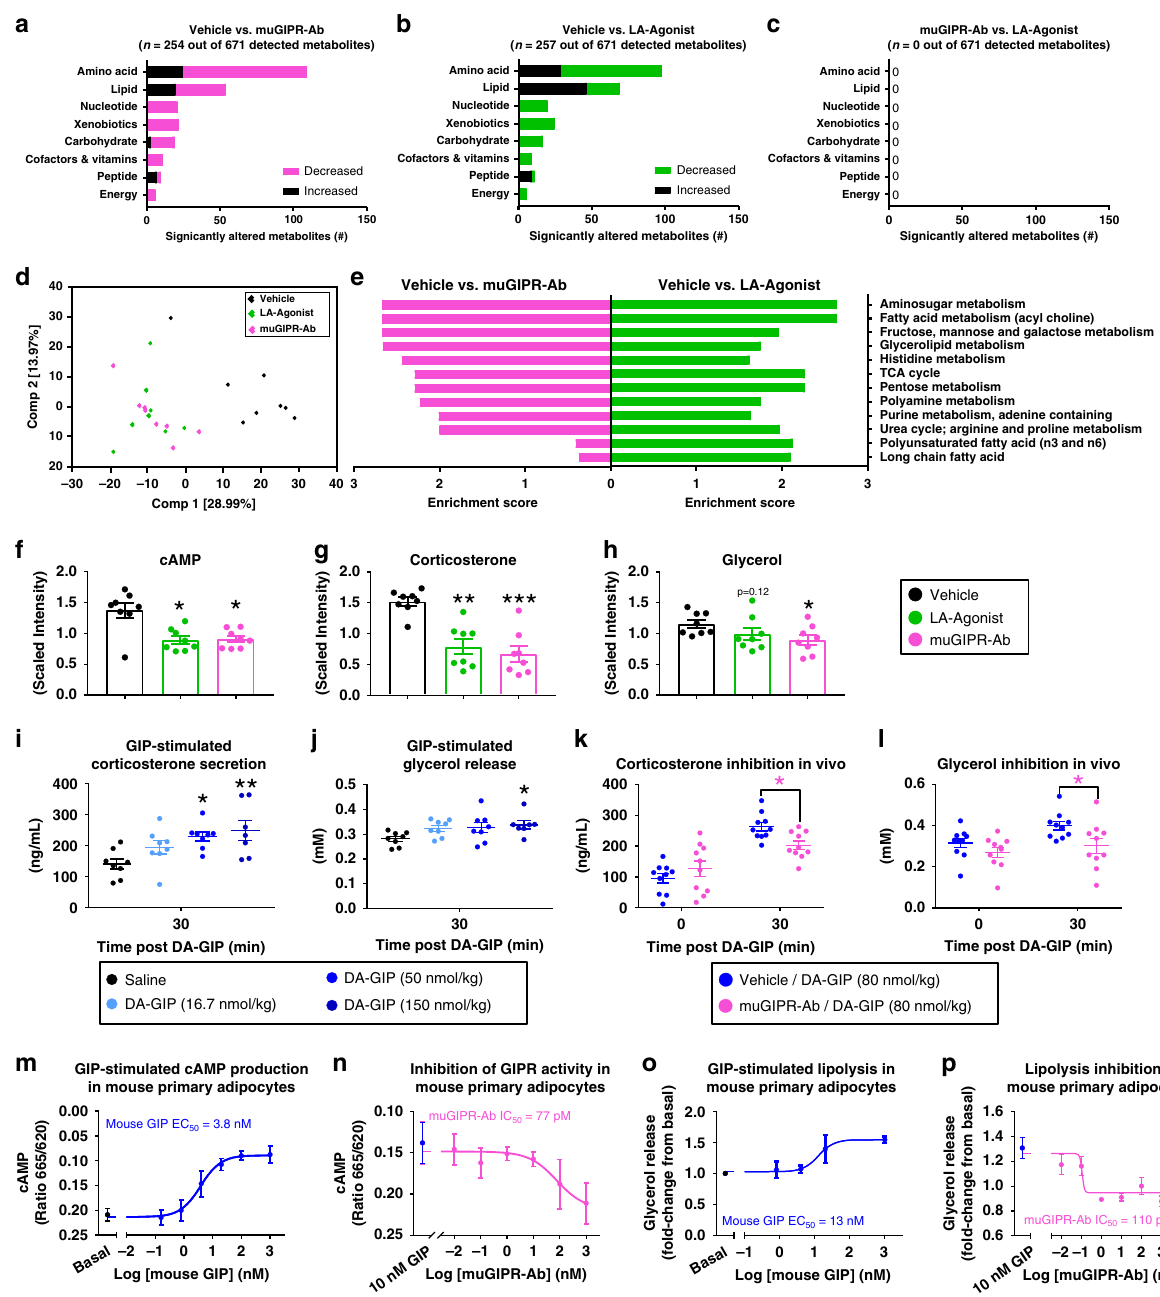
Fig. 3 Chronic LA-Agonist treatment has similar plasma metabolomics as muGIPR-Ab treatment, associated with agonist-induced receptor desensitization. a – e Global metabolomics analysis of plasma samples for vehicle, LA-Agonist, and muGIPR-Ab treated mice (presented in Fig. 2a – k). Signi fi cantly different number of metabolites between a vehicle vs. muGIPR-Ab, b vehicle vs. LA-Agonist, and c muGIPR-Ab vs. LA-Agonist. n = 8 mice/ group; Welch ’ s two-sample t -test p ≤ 0.05 and Storey method for correcting multiple comparisons q -value ≤ 0.2. d Principal component analysis (PCA) of the plasma metabolites from global metabolomics analysis. e Signi fi cantly enriched pathways between vehicle vs. muGIPR-Ab and vehicle vs. LA-Agonist treatments. f – h Plasma metabolites f cAMP, g corticosterone, and h glycerol. Data are scaled such that the median value measured across all samples was set to 1.0 ± SEM, n = 8 mice/group; Welch ’ s two-sample t -test, f Vehicle vs. LA-Agonist * p = 0.0101 and Vehicle vs. muGIPR-Ab * p = 0.0121; g ** p = 0.0023, and *** p = 0.000865; h * p = 0.029. i , j DIO mice were injected with saline or DA-GIP, and blood was collected 30 mins post-dose to measure plasma metabolites i corticosterone and j glycerol. n = 8 mice/group; one-way ANOVA with Sidak ’ s multiple comparisons test, i * p = 0.017 and ** p = 0.0047, j * p = 0.043. Data are presented as mean values ± SEM. k , l DIO mice were pre-treated with vehicle or muGIPR-Ab 24-h before injection with saline or DA-GIP and plasma metabolites k corticosterone and l glycerol were measured over time. n = 10 mice/group; two-way repeated measures ANOVA with Sidak ’ s multiple comparisons test, k * p = 0.043, l * p = 0.029. Data are presented as mean values ± SEM. m , n cAMP concentration in mouse primary adipocytes ( m ) treated with GIP or ( n ) pre-treated with muGIPR-Ab overnight then treated with 10 nM mouse GIP. Data represents means ± SEM of three mice with three wells/treatment/mouse. o , p GIP-stimulated lipolysis in primary differentiated mouse pre-adipocytes o treated with mouse GIP compared to basal or p after pre-treatment with muGIPR-Ab overnight then treated with 10 nM mouse GIP. Data represent means ± SEM of 3 – 6 mice with three